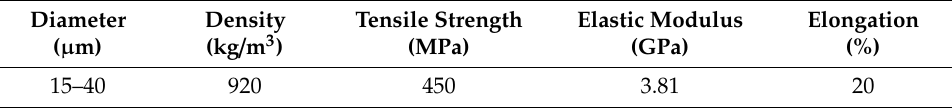
Table 4. Main physical and mechanical properties of polypropylene fiber (PP).